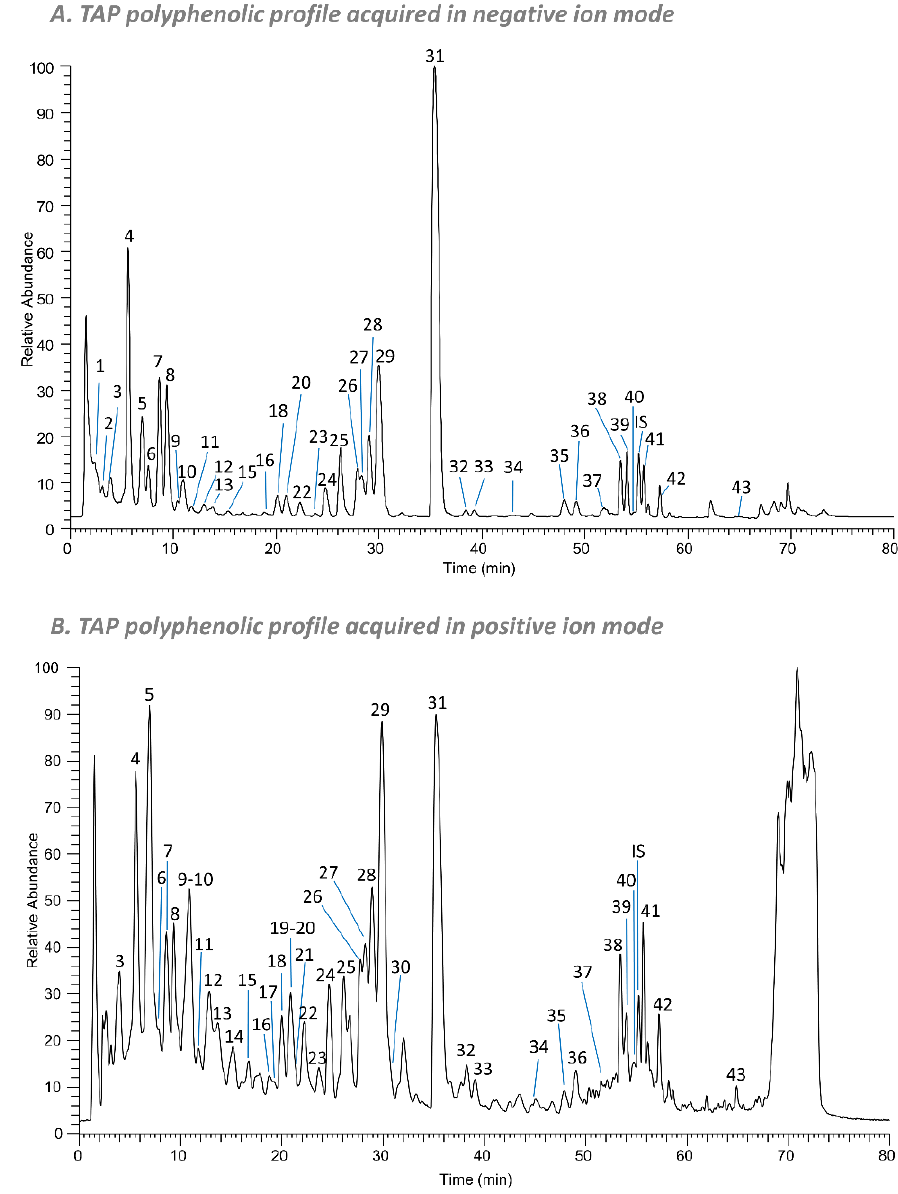
Figure 2. Total ion currents (TICs) of PAT fraction acquired in ( A ) negative ion mode and ( B ) positive ion mode. Identified peaks are numbered progressively, according to the elution order, and their identity or putative identity is shown in Table S1 of the Supplementary Materials with the experimental mass, MS/MS fragments and identification method. IS: internal